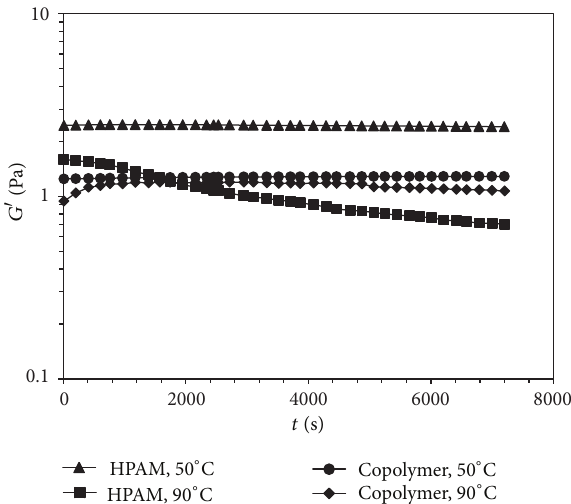
Figure 7: Comparison of G 󸀠 of HPAM and ATBS-AM copolymer solutions in deionized water by time sweep measurements at 0.25% polymer concentration.